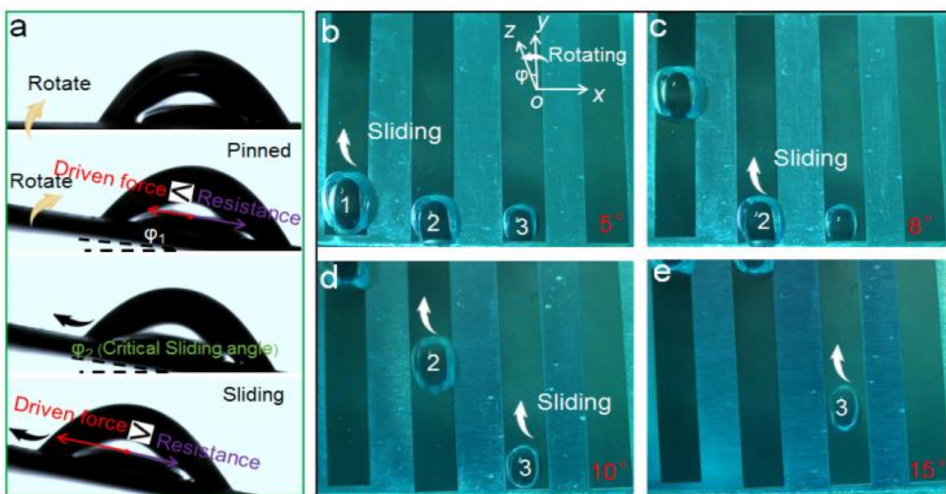
Figure 3. The directional transmission process of the underwater bubble on the restricted LIAMSS. ( a ) Side view of bubble sliding with the increase in incline angle. ( b – e ) The sliding process of underwater bubbles at different volumes on the restricted LIAMSS. It can be clearly seen that the bubbles with different volumes start to slide on the inclined LIAMSS at different rotating angles, which is mainly induced by the variation in bubble buoyancy along the incline direction. The adhesion force between the bubble and the oil layer is also important in controlling the directional movement of bubbles, which could be regarded as the viscous resistance during the sliding